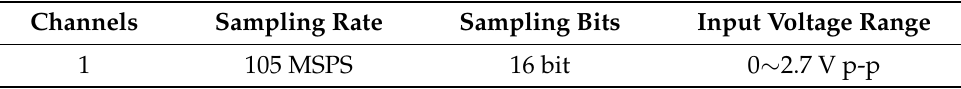
Figure 8. The waveforms of v 1 ( CH 1 ) and v 3 ( CH 3 ) . Table 1. The main parameters of the high-speed parallel analog-to-digital converter